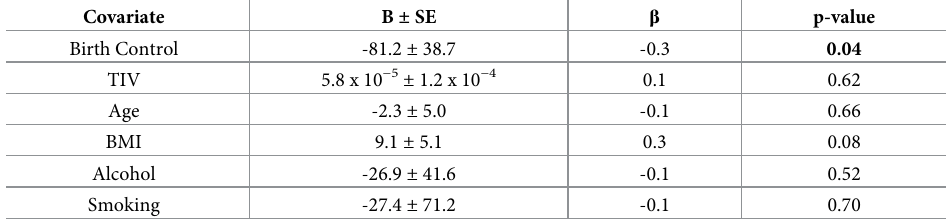
Table 3. Regression model for pituitary